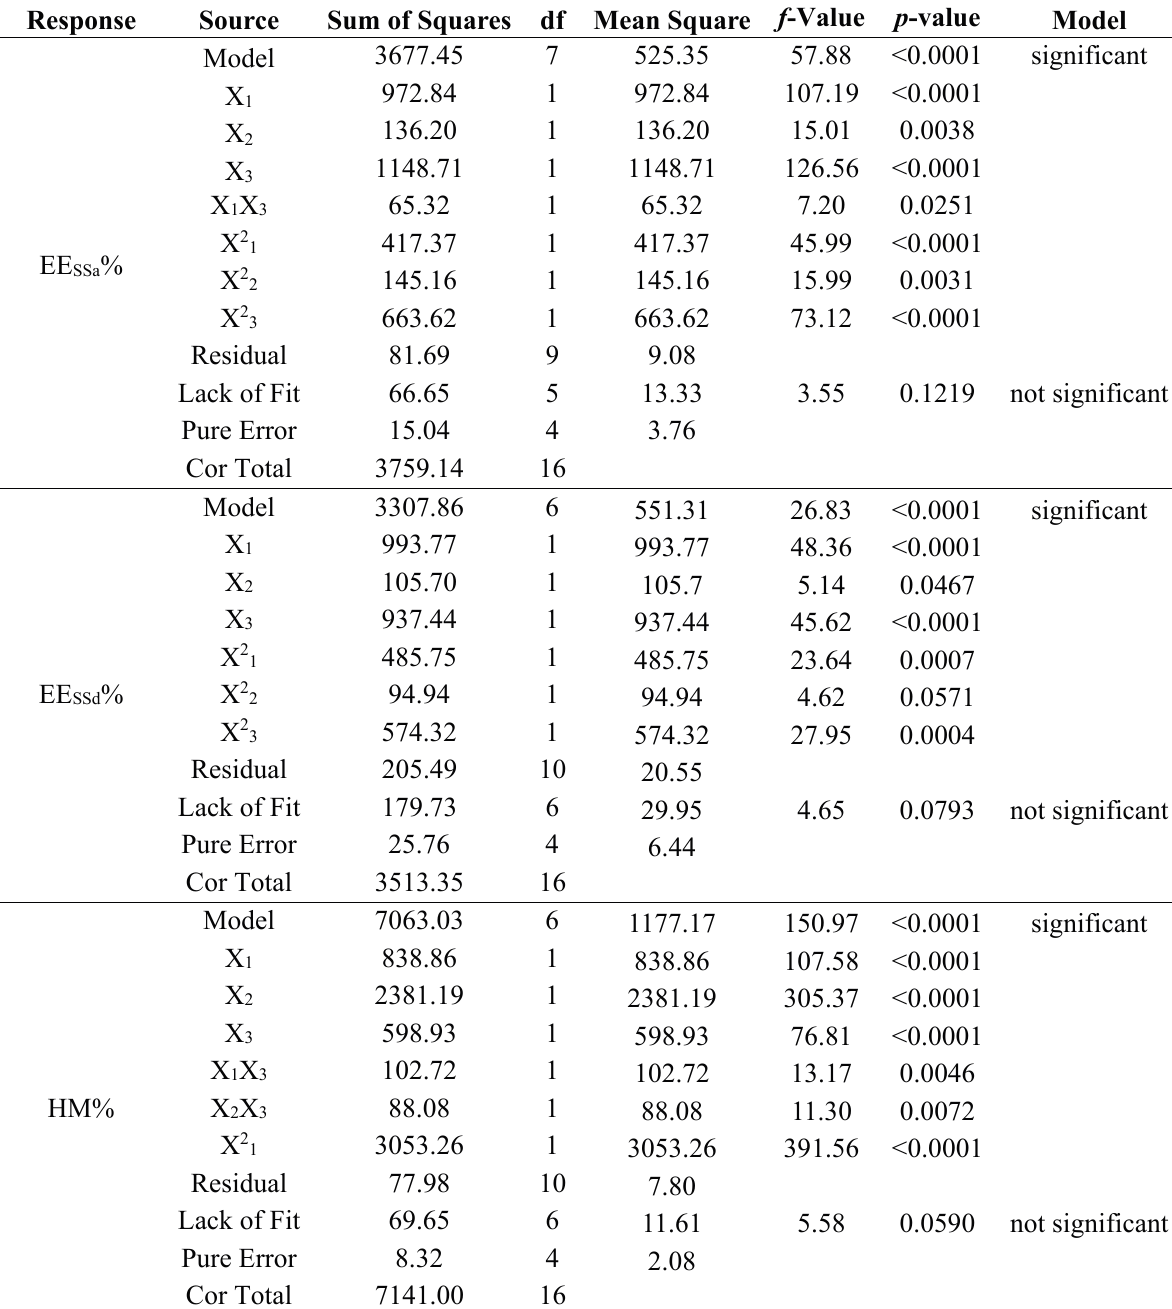
Table 6. Analysis of variance (ANOVA) for the regression